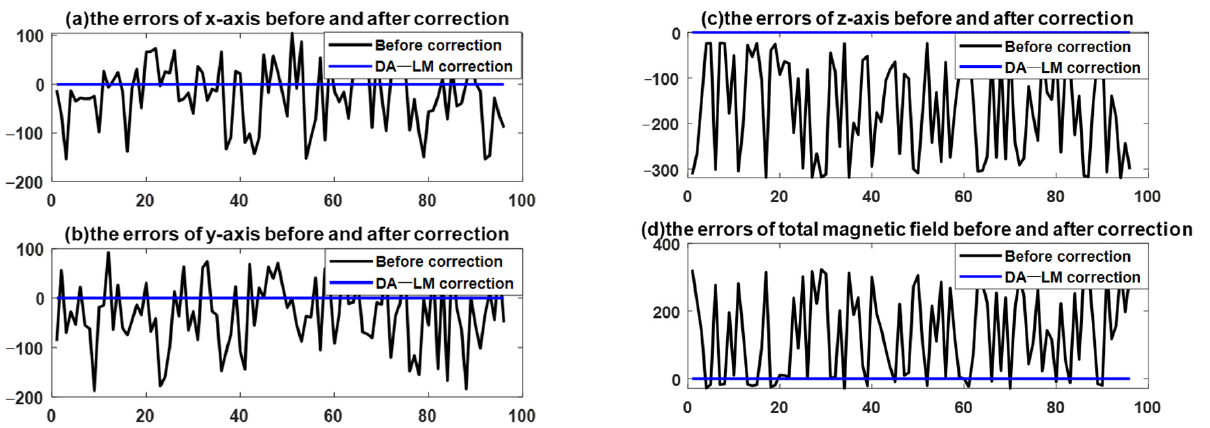
Figure 4. The errors of components and total magnetic field before and after correction. ( a ) The errors of the x -axis; ( b ) The errors of the y -axis; ( c ) The errors of the z -axis; ( d ) The errors of measured total magnetic field before and after correction.